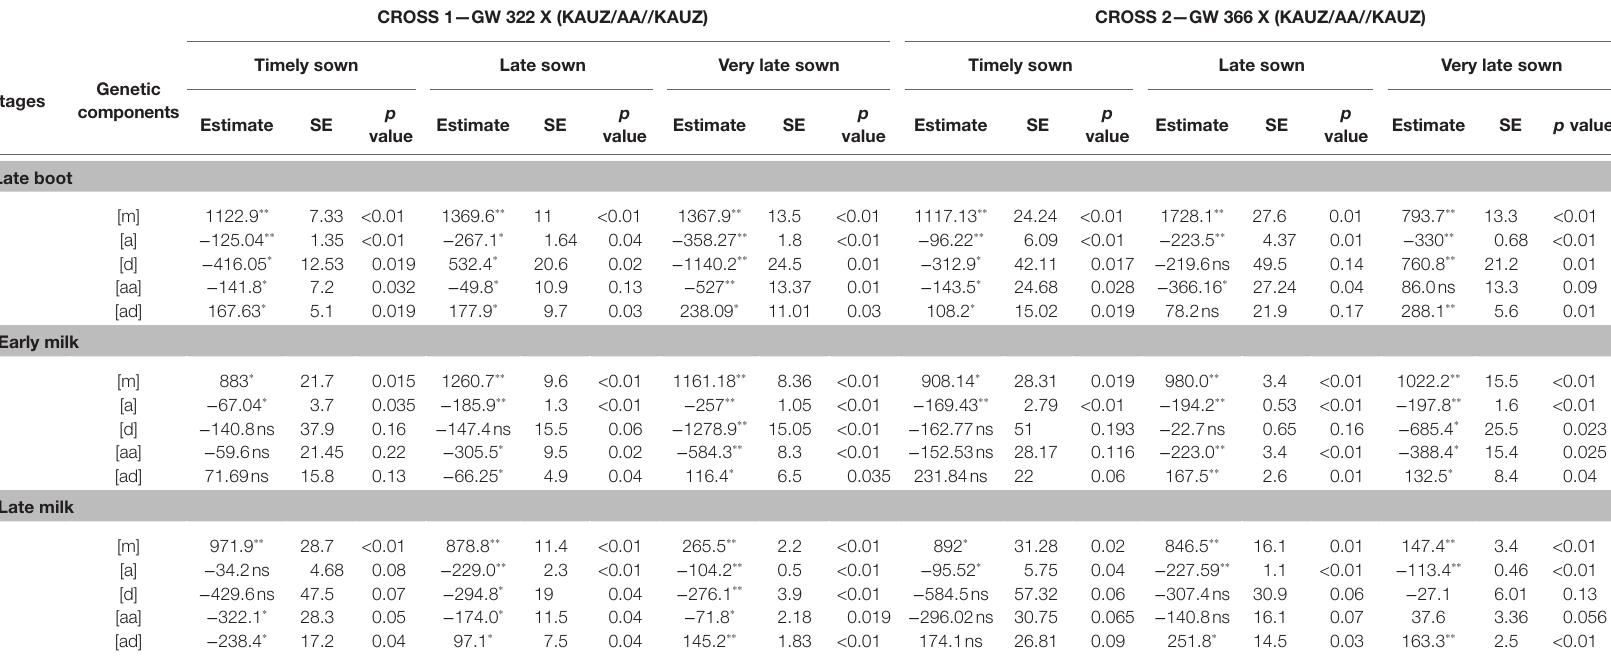
TABLE 6 | Estimates of genetic components, mid-parent [m], additive effect [a], dominance effect [d], additive X additive [aa], dominance X dominance [dd], additive X dominance [ad], standard errors (SE), and Student’s t significance level ( P ) for the models with the best Chi-square fit for stomatal conductance measured parents, F 1 , F 2 , BC 1 P 1 and BC 2 P 2, for GW 322 X (KAUZ/AA//KAUZ) and GW 366 X (KAUZ/AA//KAUZ) during three growth stages under timely, late, and very late sown condition. CROSS 1—GW 322 X (KAUZ/AA//KAUZ) CROSS 2—GW 366 X